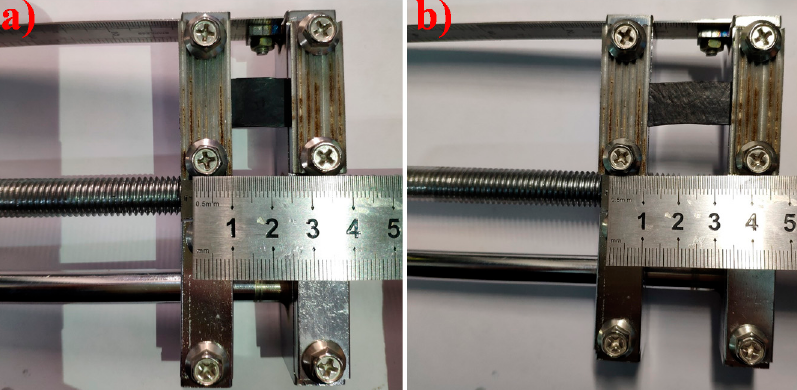
Figure 2. The machine that used to test the rubber permanent deformation properties ( a ) original; and ( b ) pulled for 50% strain.